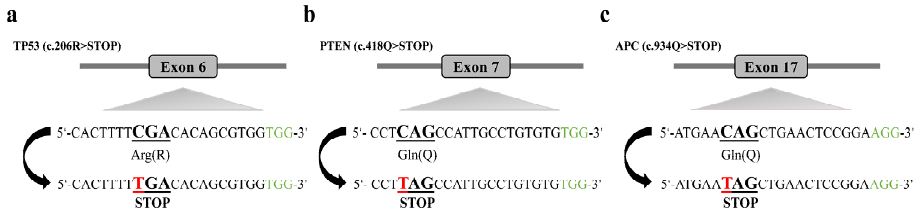
Figure 1. The target sequences at the TP53 ( a ), PTEN ( b ), and APC ( c ) loci. PAM sequences are added to the 3 ′ end (marked in green); codons with intended C − to − T conversion are underlined; and the C to be converted (to T) is indicated in red.